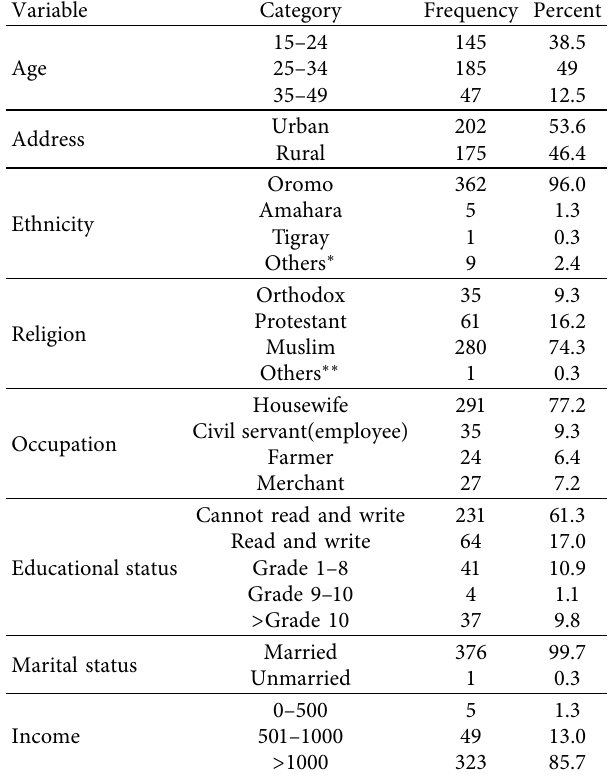
Table 1: Sociodemographic characteristics of adverse perinatal and maternal outcome and associated